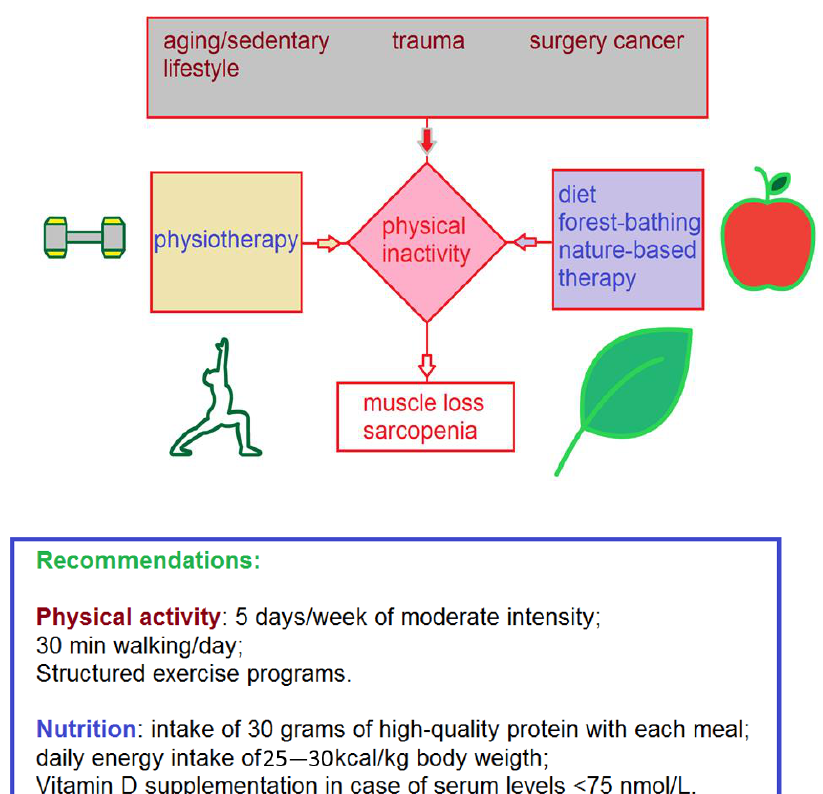
Figure 1. Schematic description of the main issue, including the complications of multicausal physical inactivity, as well as the patients’ main management strategies and recommendations illustrated in this work.